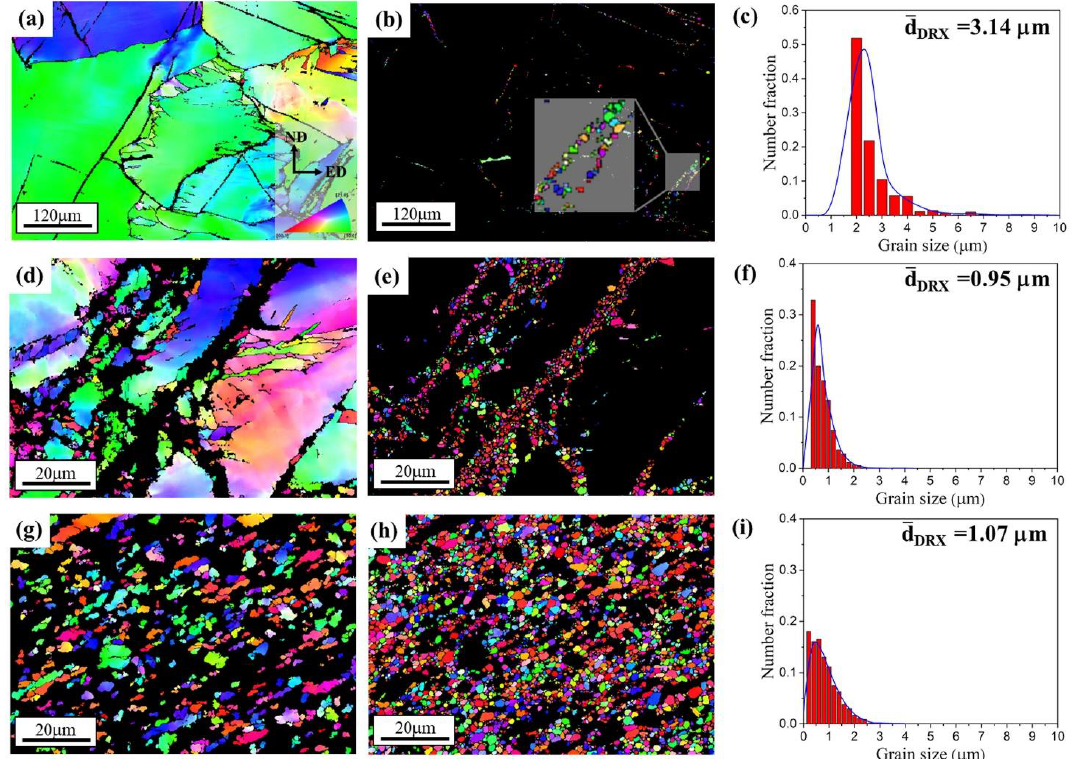
Figure 6. Separated EBSD maps of ( a , d , g ) deformed grains and ( b , e , h ) DRX grains. The grain size distribution of DRX grains is presented in ( c , f , i ) by the number